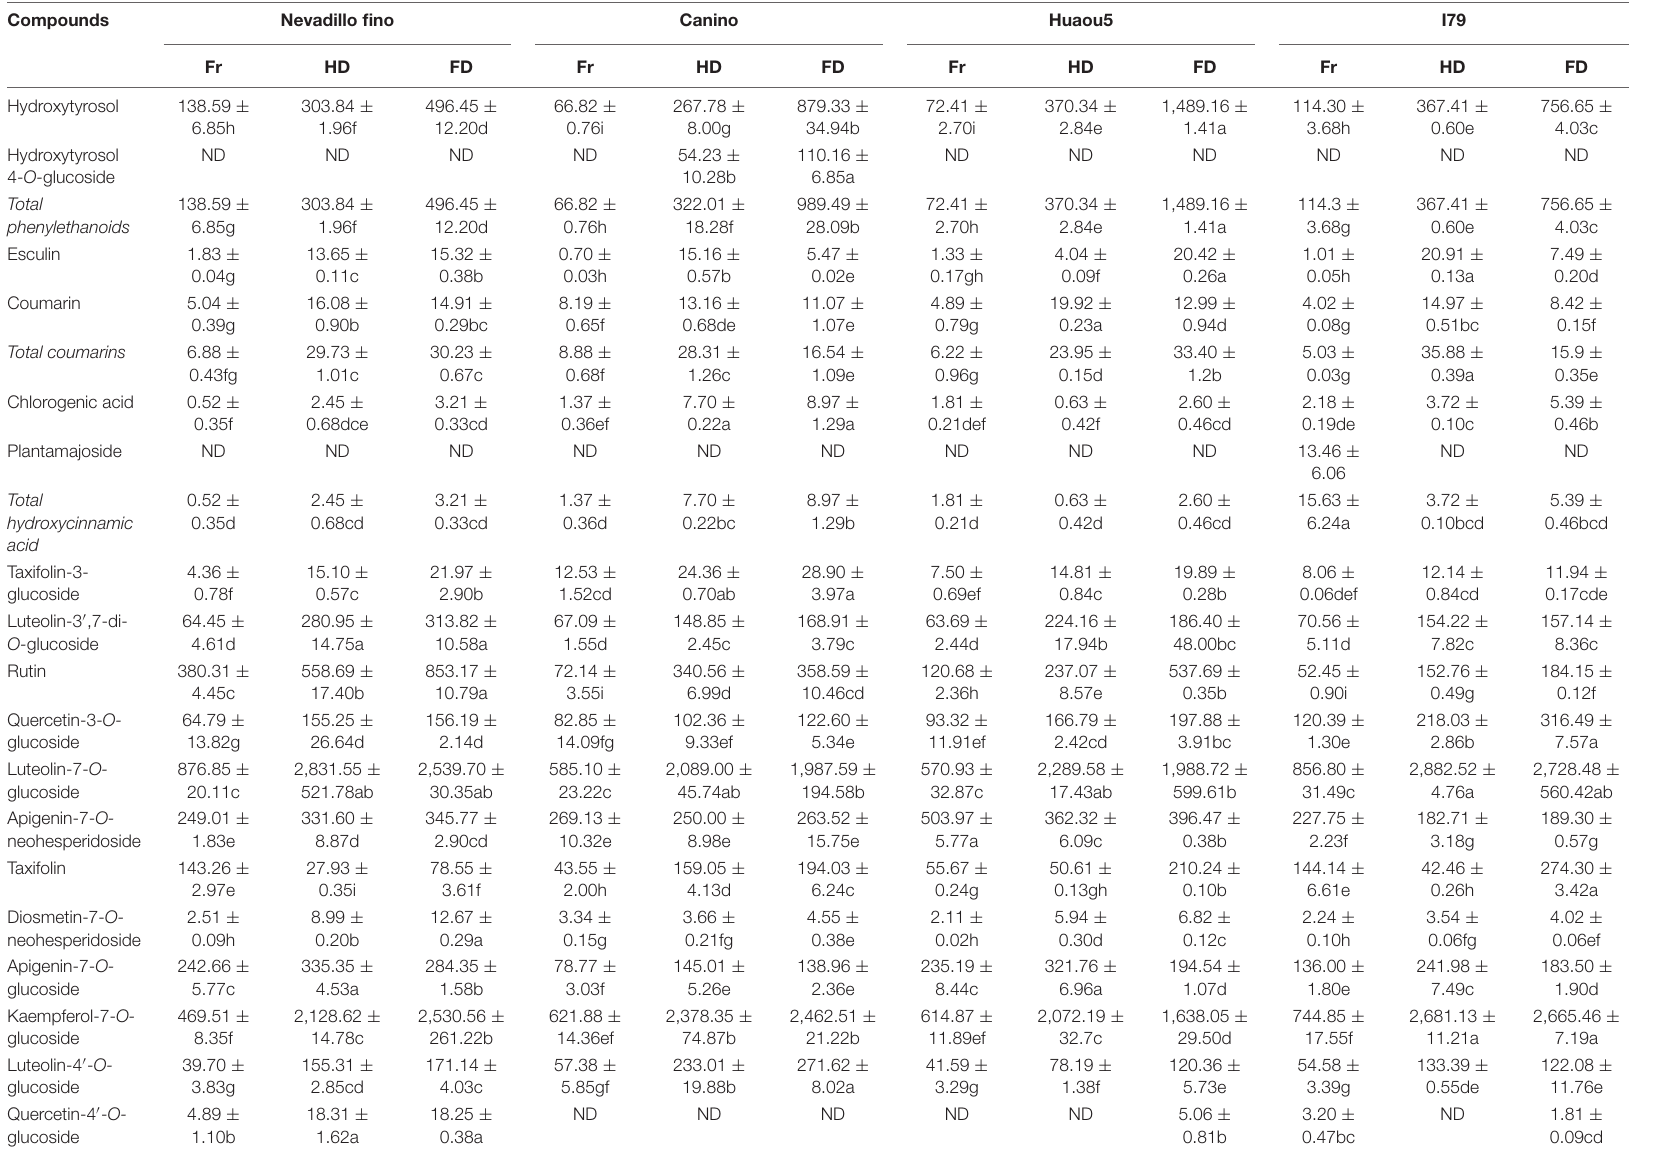
TABLE 3 | Concentrations of individual phytochemicals identified in olive